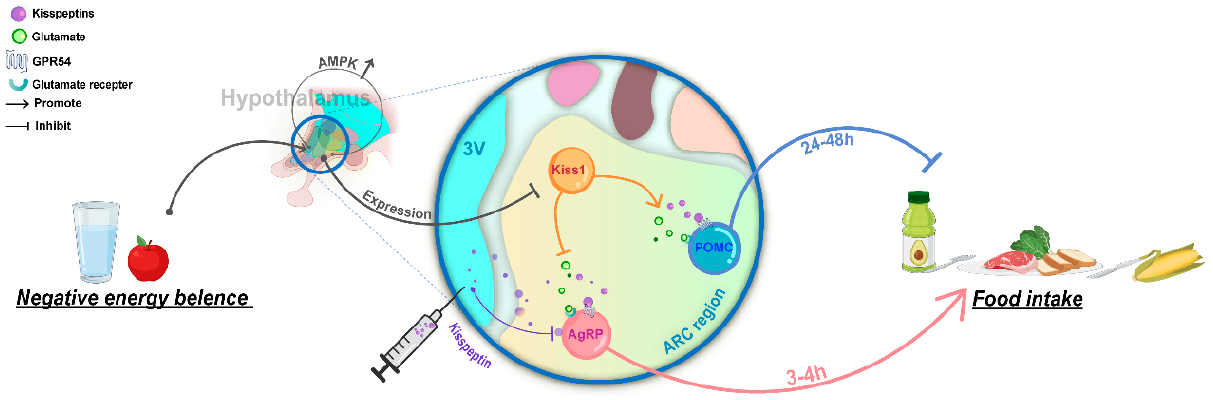
Figure 2. Hypothalamic Kiss1/GPR54 system regulation on food intake. Negative energy balance activates hypothalamic AMPK , which decreases Kiss1 expression. The Kiss1 neurons control food intake in the ARC region via signaling molecules AGRP and POMC neurons, improving the negative energy status. In addition, injection of exogenous kisspeptin reduces food intake by inhibiting AGRP neurons.